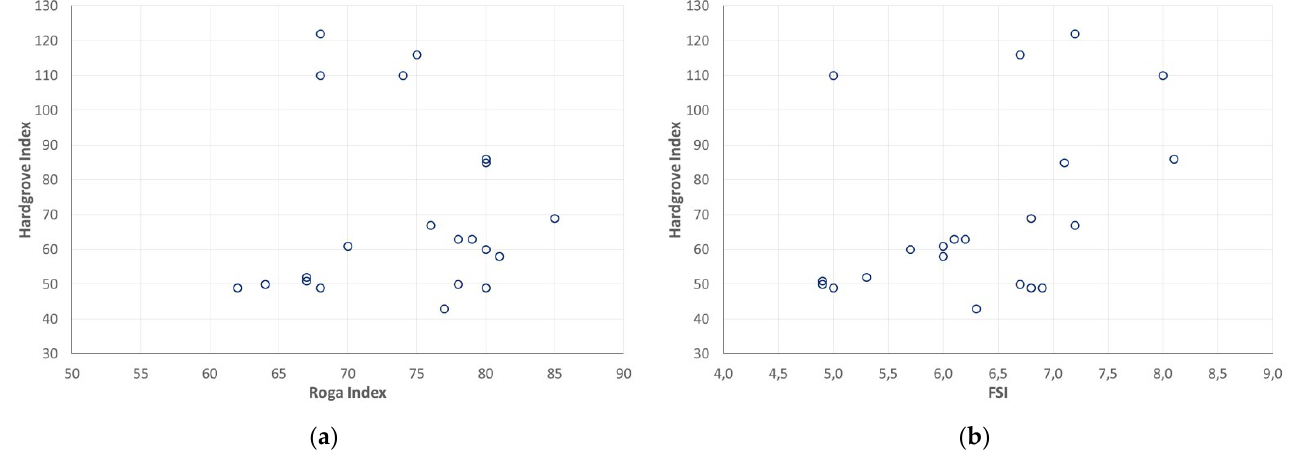
(c) Figure 6. The value of Hardgrove index as a function of coking parameters of the coals studied: ( a ) Roga index, ( b ) free swelling index and ( c ) dilation. Figure 7. Hardgrove index values versus caloric values of tested coals.